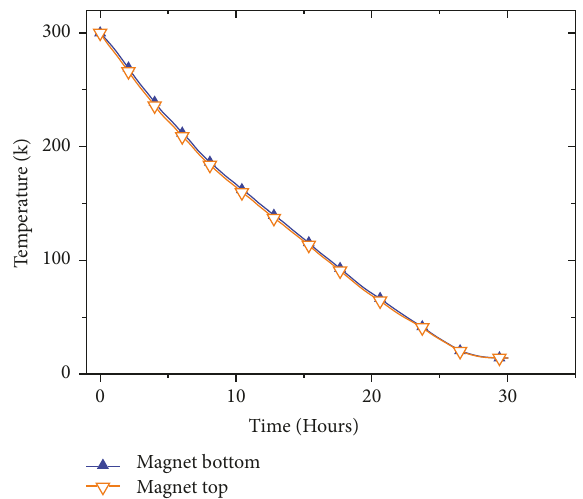
Figure 6: Temperature variation of the magnet in cooling process.